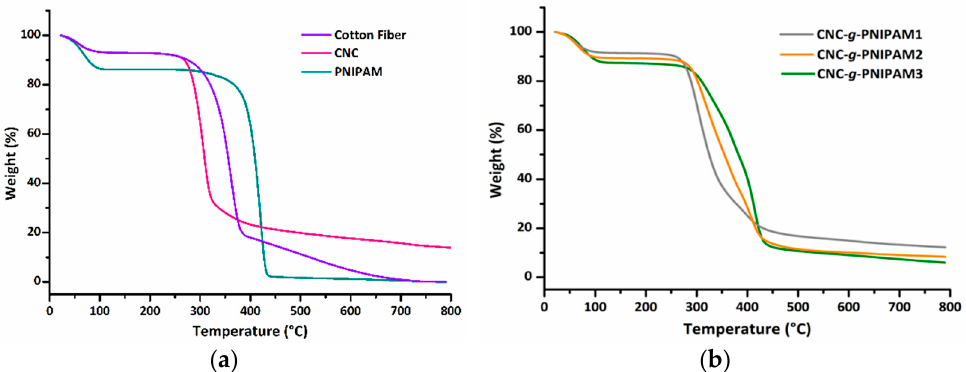
Figure 5. Thermogravimetric curves of ( a ) cotton fibers (CFs), cellulose nanocrystals (CNCs), and PNIPAM; ( b ) CNC- g -PNIPAM1, CNC- g -PNIPAM2, and CNC- g -PNIPAM3. PNIPAM; ( b ) CNC- g -PNIPAM1, CNC- g -PNIPAM2, and CNC- g